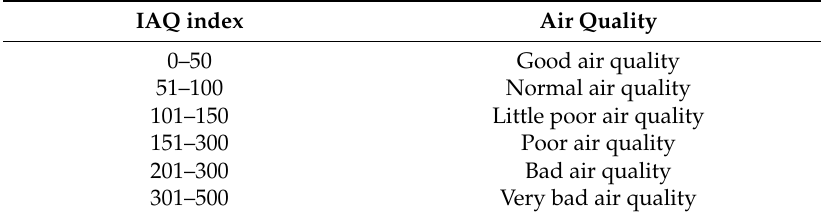
Table 2. BME680 qualitative IAQ index meaning.